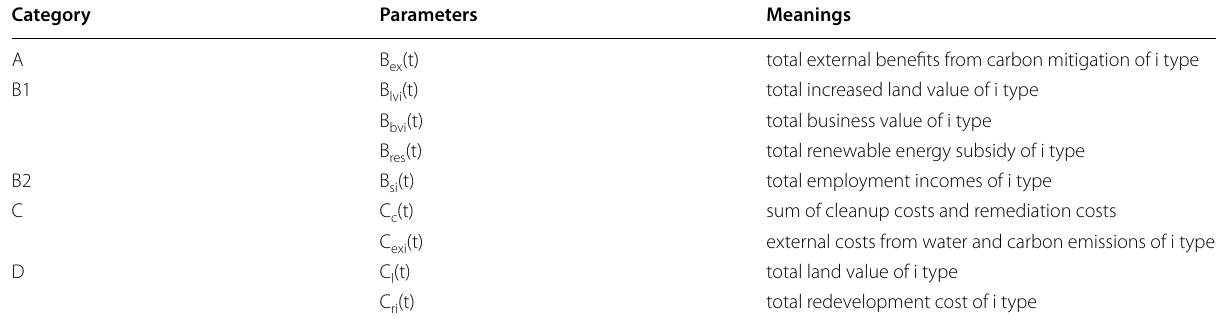
Table 3 The meaning of each parameter for the BRQ model Category